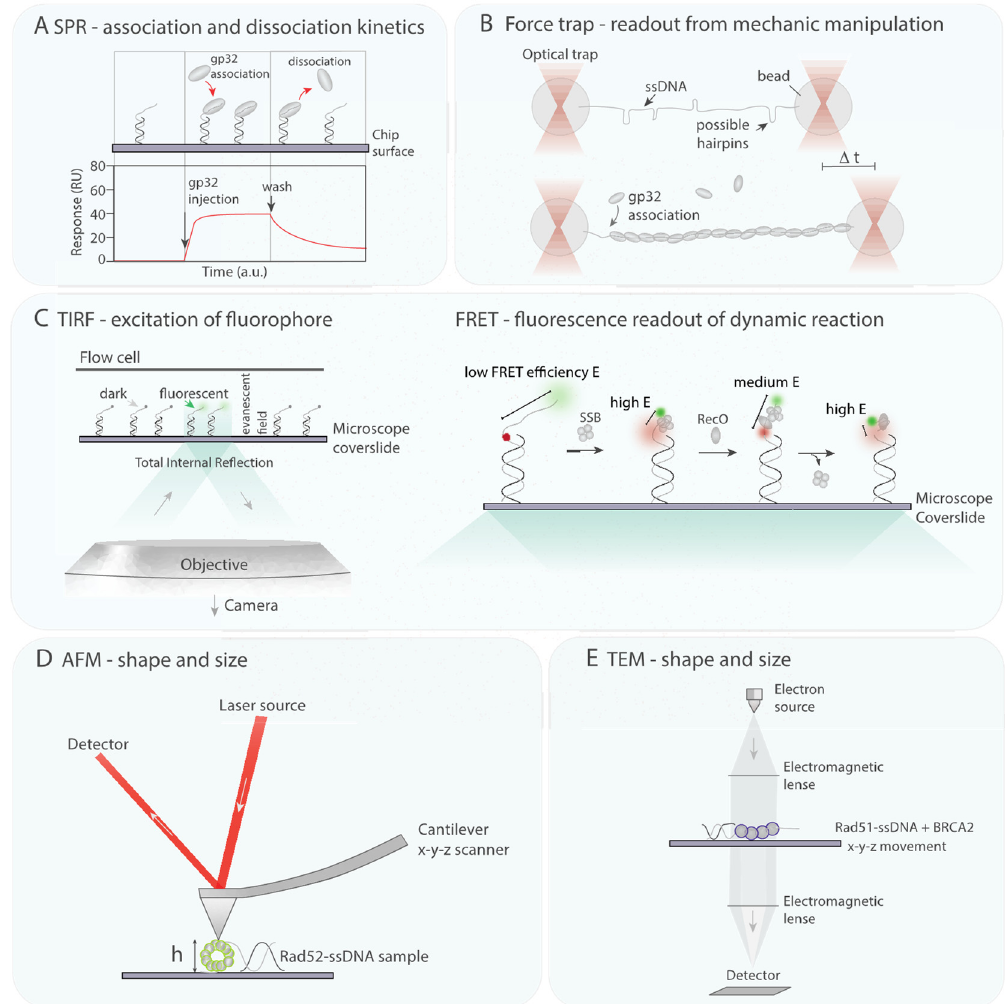
Figure 3. In vitro biophysical tools. ( A ) Surface plasmon resonance (SPR) binding analysis is used to determine binding affinities. On a chip, measuring mass adsorption and/or desorption can unveal kinetics of binding processes. Illustrated here is association and dissociation of gp32 with ssDNA [80]. ( B ) Force traps (optical and mechanical tweezers) can hold each end of linear DNA, to determine differences in mechanical properties of DNA upon protein binding. Association of single-strand binding protein gp32 for instance prevents the formation of ssDNA secondary structure [126]. ( C ) Left : TIRF microscopy excites fluorescent molecules close to a microscope coverslip in evanescent field. Molecules can be bound to DNA that is tethered to the coverslip surface. Right : Förster Resonance Energy Transfer (FRET) spectroscopy coupled with TIRF setting permits to study molecular mechanisms of two molecules approaching at a distance of several